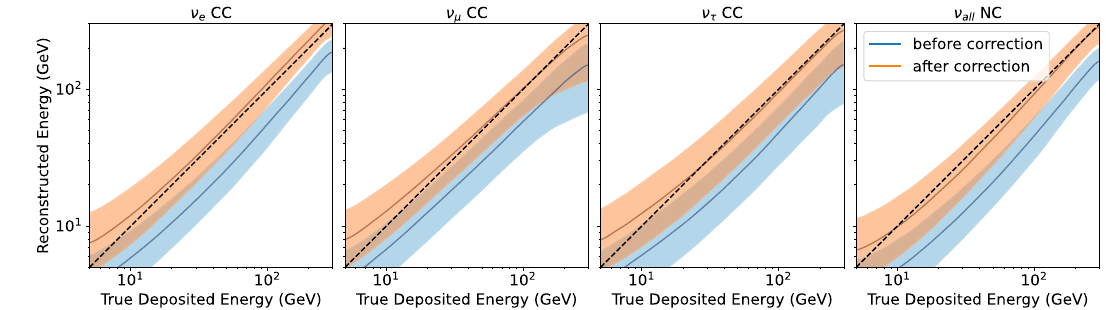
Fig. 13 Reconstructed energy before and after the bias correction is applied.Thisbiascorrectionisappliedtomakethereconstructedenergy a better estimator of true deposited energy. The shaded region shows the 68% containment regions, and the solid line shows the median. The